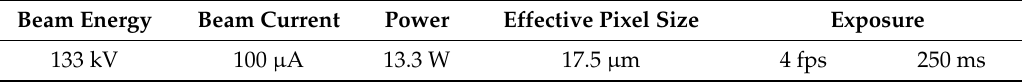
Table 1. Scanning parameters of µ -CT